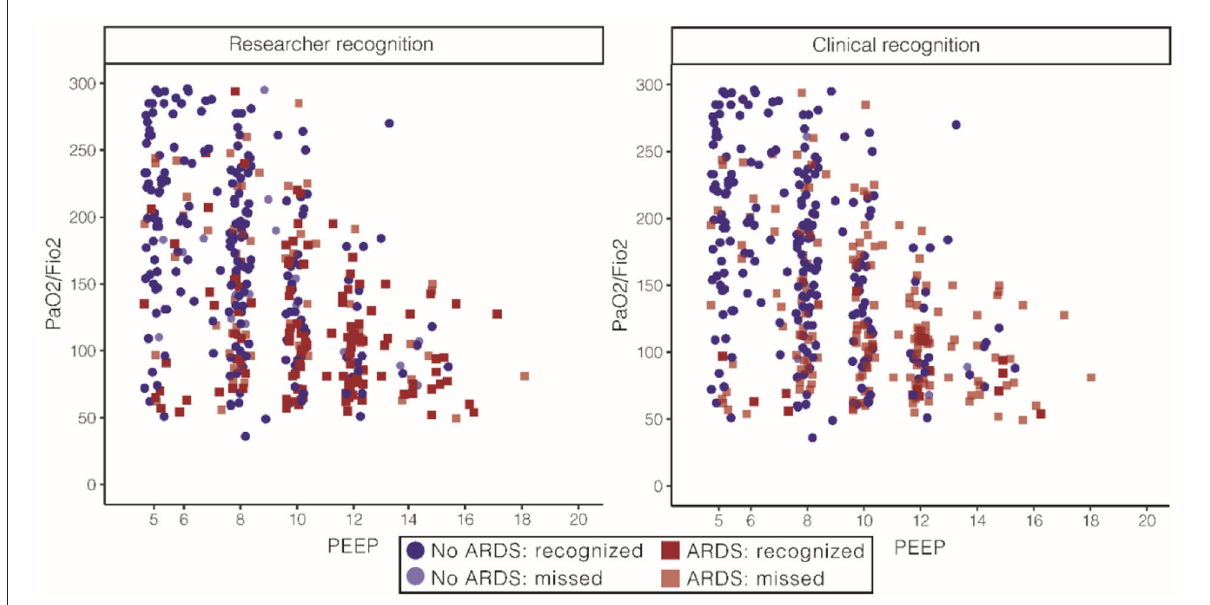
FIGURE5 Face validity of ARDS for the expert panel, stratified for researchers and clinical diagnoses. On the left, patient characteristics as recognized by the research team. The research team recognized 66% of the patients classified as ARDS by the expert panel. PaO 2 /FiO 2 108 [77, 143] in the ARDS group and 167 [109, 223] the in no ARDS group and PEEP of 10 (8, 12) in the ARDS group and 8 (6, 10) in the no ARDS group [numbers represent median (IQR)]. On the right, patient characteristics as recognized by the clinical team. The clinical team recognized 86% of the patients classified as ARDS by the expert panel. PaO 2 /FiO 2 85 [68, 100] in the ARDS group and 144 [98, 201] in the no ARDS group and PEEP of 12 (8, 13) in the ARDS group and 8 (7, 10) in the no ARDS group [numbers represent median (IQR)]. ARDS, acute respiratory distress syndrome; FiO 2 , fraction of inspired oxygen; PaO 2 , partial pressure of oxygen; PEEP, positive end-expiratory